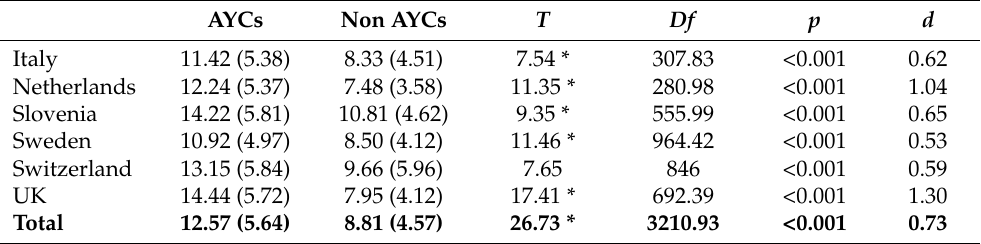
Table 5. T -tests on mean MACA score (SD) for AYCs and 15–17-year-old non-carers, separately for each country.